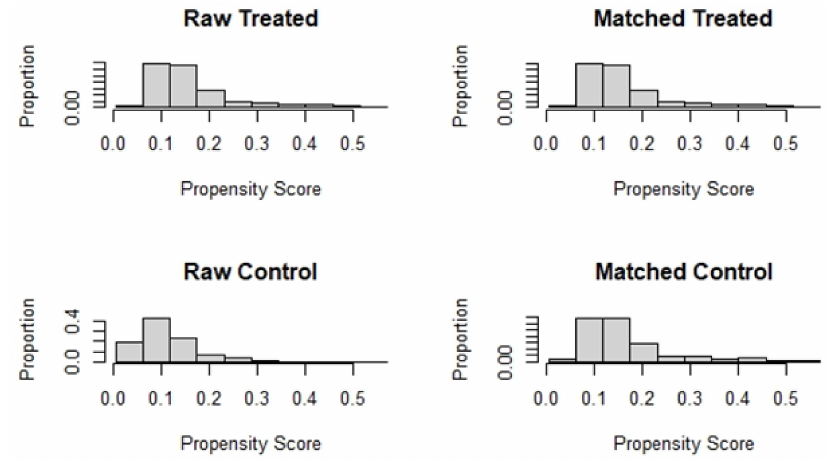
Figure 3. Histogram of data distribution before and after matching.